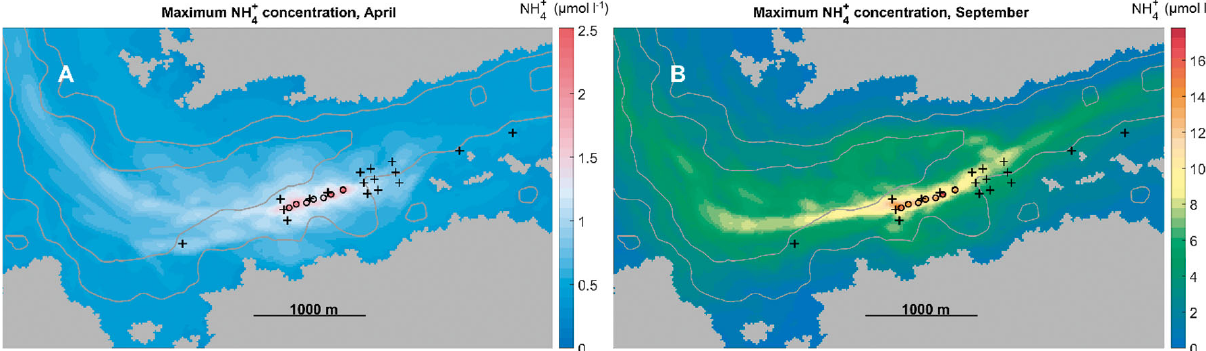
Fig. 6. Time-integrated maximum ammonium concentrations as observed for each grid cell in the simulation model during the entire month of (A) April and (B) September. Circles indicate the salmon cages, and black crosses are the sampling stations as outlined in Fig. 1. The plots show a subregion of the model domain used. The color maps correspond qualitatively with those used in Fig.